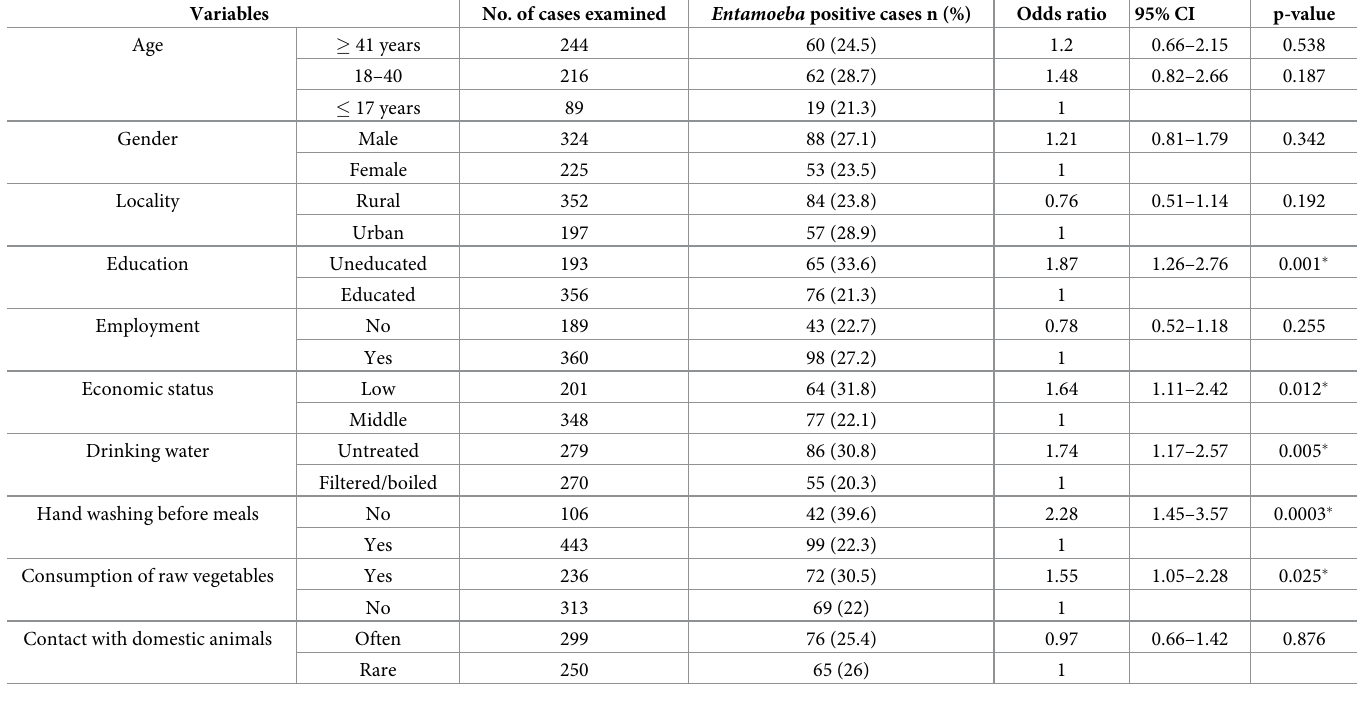
Table 2. Univariate analysis of factors associated with presence of Entamoeba spp. (n = 549).